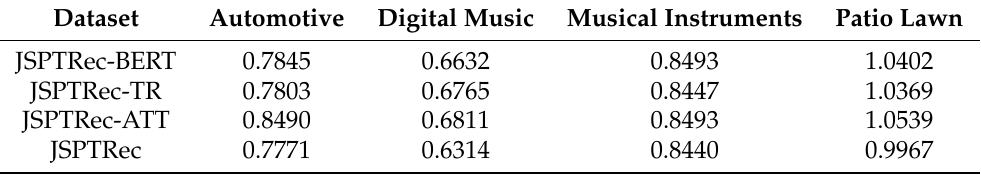
Table 4. Ablation